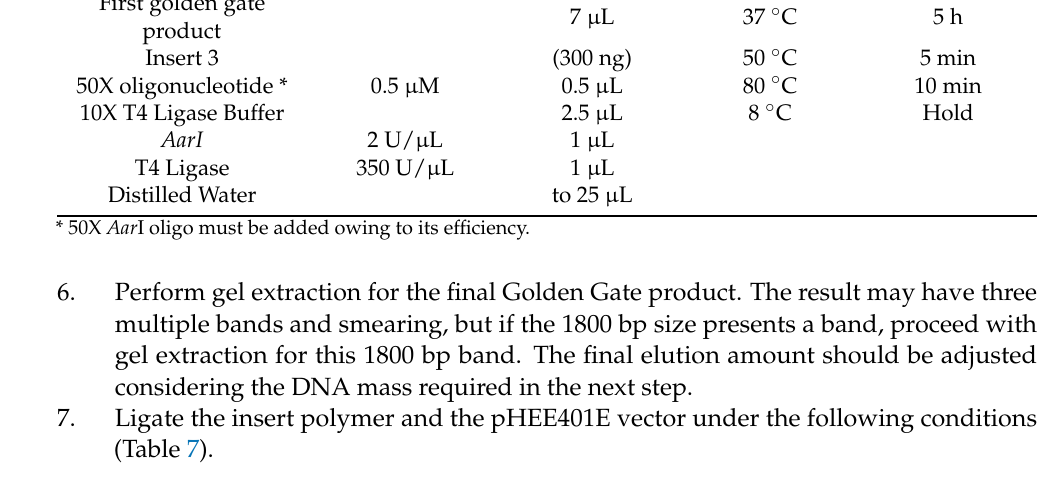
Table 7. Golden Gate reaction components and thermal